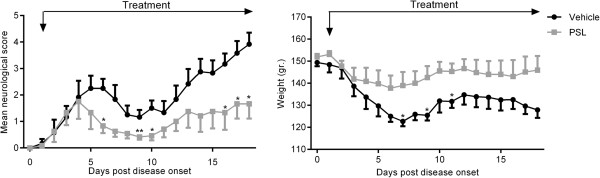
PSLs have a therapeutic effect on EAE. MOG-immunized animals were treated daily with PBS (n=6; black) or 5 mg/kg PSLs (n=6; light grey) starting at disease onset. Neurological score and weight was assessed daily. Data represent the mean ± SEM.